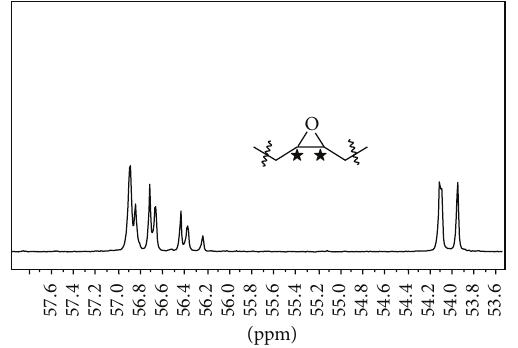
Figure 2: 13 CNMR spectral region of milkweed polyoxirane.